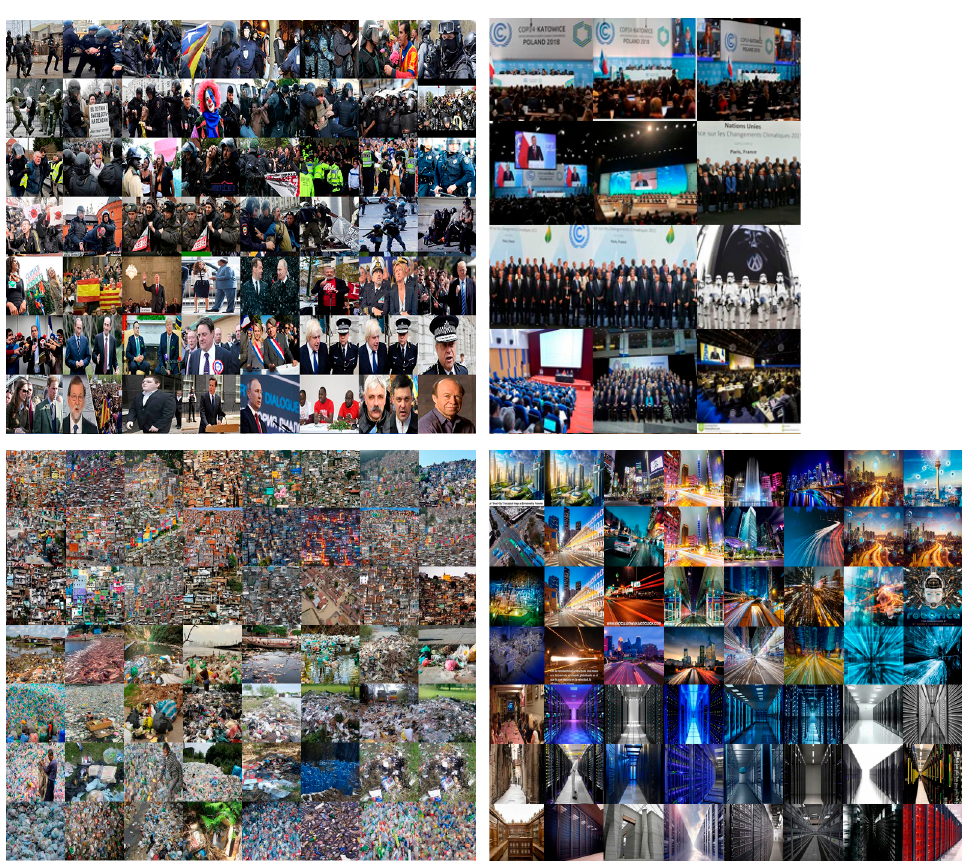
Figure 20. Expanded details of the different maps. © Pilar Rosado.